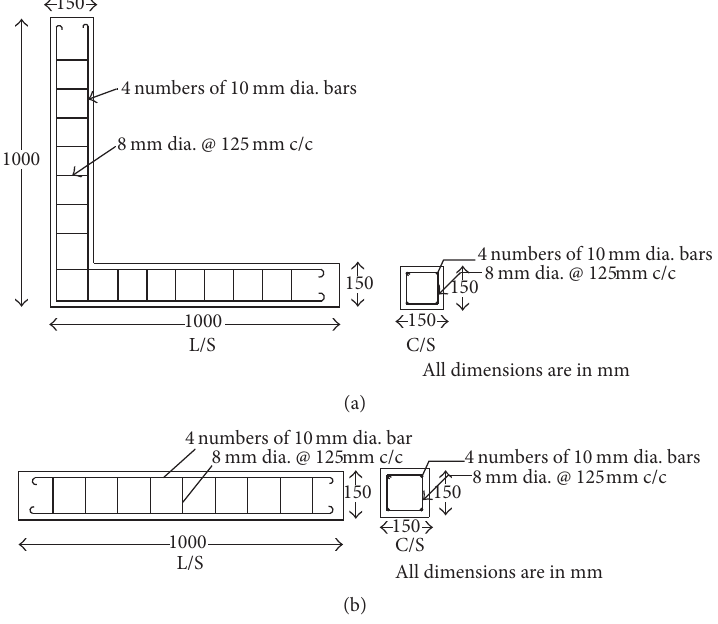
Figure 4: Reinforcement details of elements.